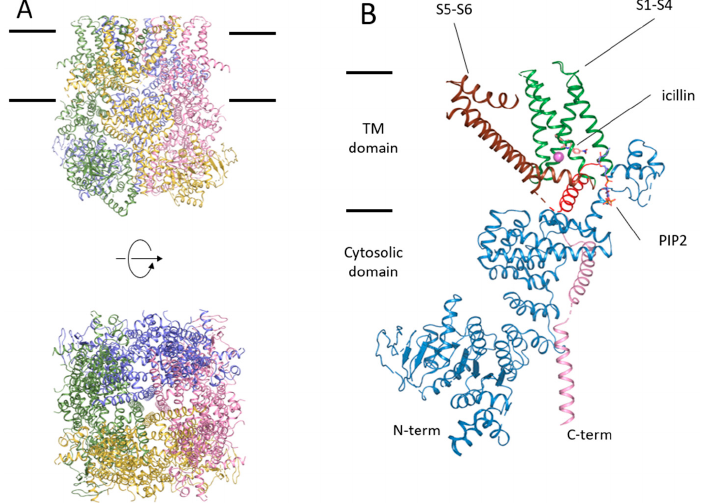
Figure 6. Structure of TRPM8 in the presence of the activator icilin, calcium, and PIP 2 (PDB code: 6NR3 [106]). ( A ) front and top views of TRPM8 in colored cartoons. Black bars indicate the approximated location of the lipidic membrane. ( B ) Structural representation of a single subunit of TRPM8, showing the transmembrane and the cytosolic part. Colored domains are cytosolic N ‐ terminus (sky ‐ blue); S1–S4 voltage sensor ‐ like domain (green); S5 and S6 (brown); TRP helix (red); and C ‐ terminus (pink). Effectors are represented in sticks: icilin in light orange, PIP 2 in blue/red, and calcium in sphere pink.